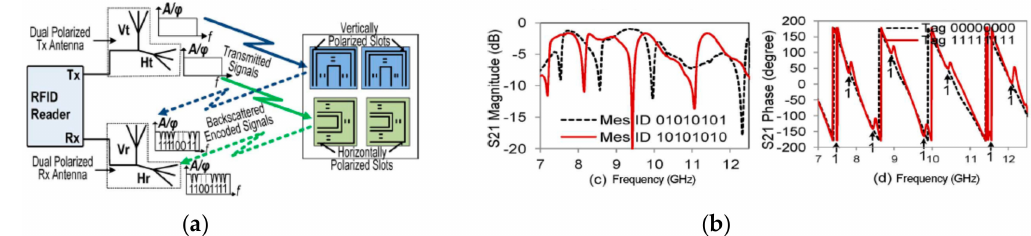
Figure 23. ( a ) Chipless-RFID based on polarization diversity proposed by Islam et al. and ( b ) measured frequency response of a tag with the indicated code. Figure extracted from [93].